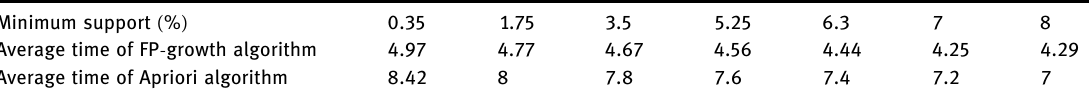
Table 2: Average mining time for di ff erent minimum support values Minimum support ( %